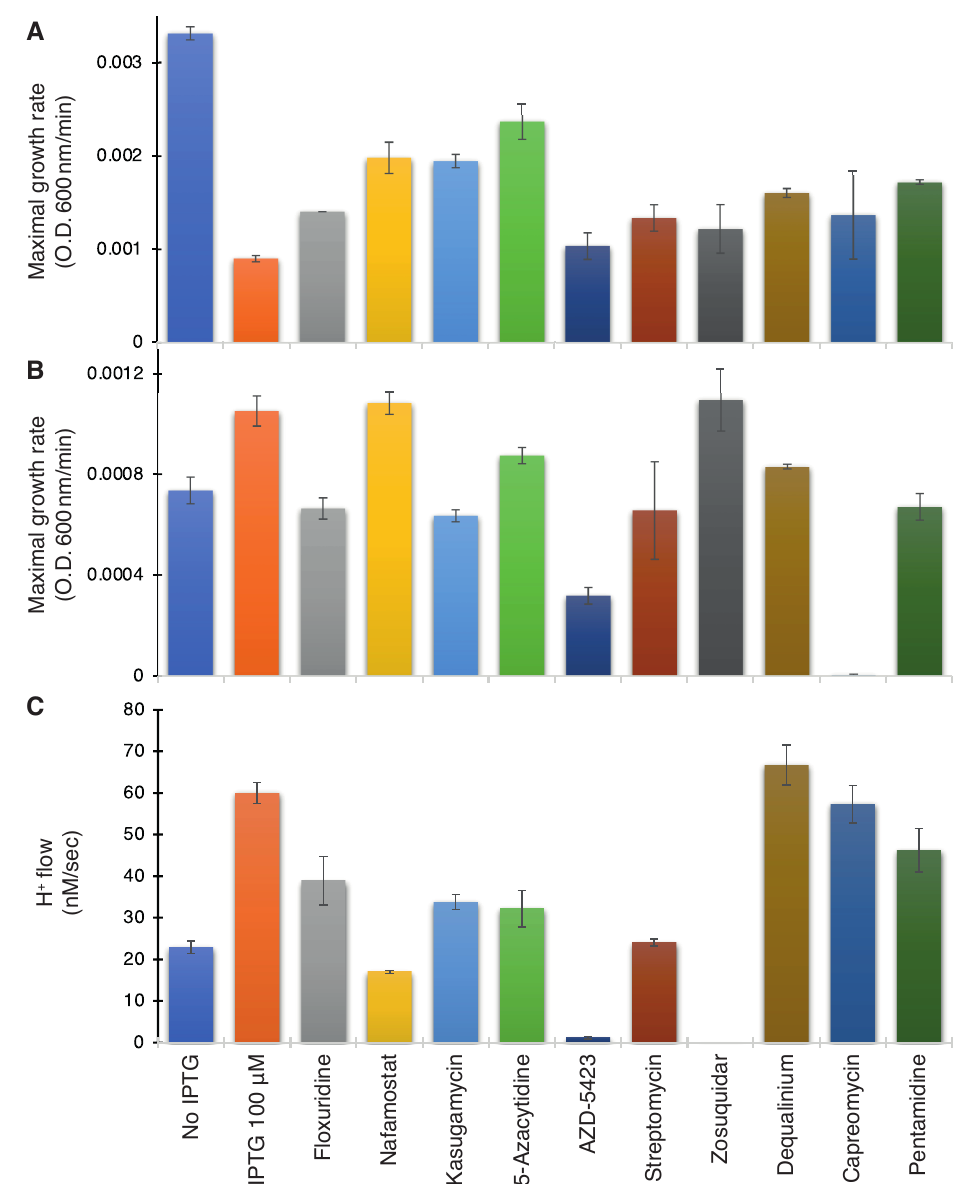
Figure 6. Drug screening on wild-type ZikV-M. Maximal growth rate as a function of the different drugs (100µM) in the negative genetic assay ( A ) or positive ( B ) assays. ( C ) Effect of drugs on proton flow examined on bacteria that express a pH-sensitive GFP [38]. Note, that effective compounds are expected to increase the growth rate in the negative assay ( A ), decrease growth in the positive assay ( B ), and decrease H + flow in the pH-assay ( C